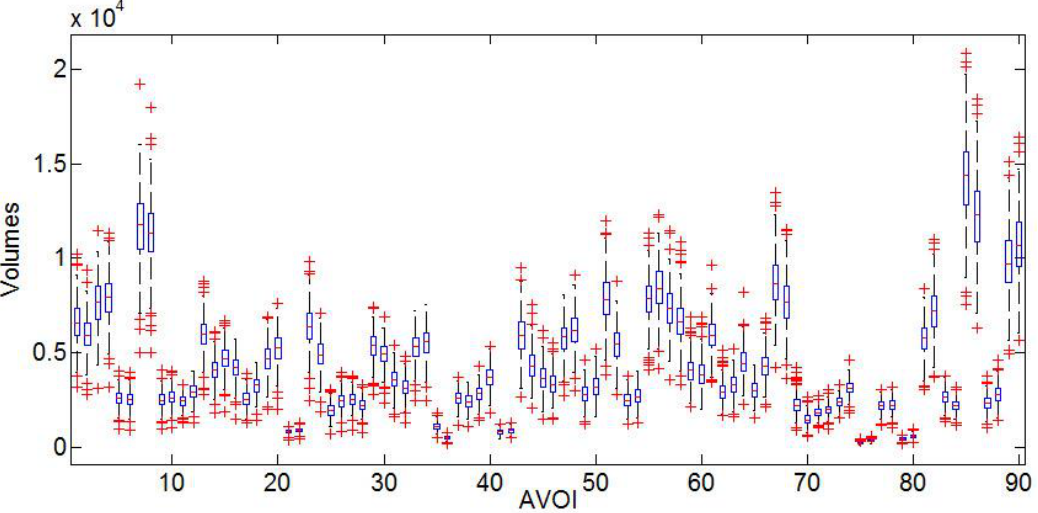
Figure 3. Mild cognitive impairment (MCI) grey matter volume Box-plot.